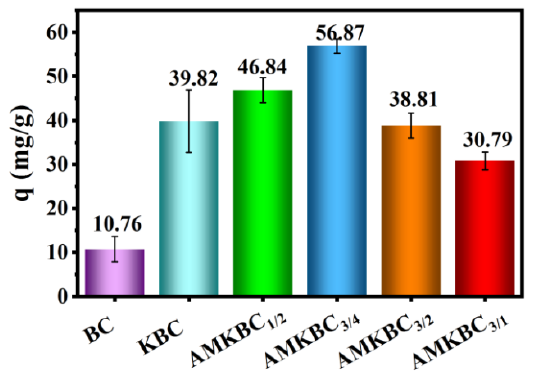
Figure 1. Cr(VI) adsorption capacity of various biochars: initial pH; T = 5 h; m = 0.01 g; V = 30 mL; C 0 = 100 mg L − 1 .